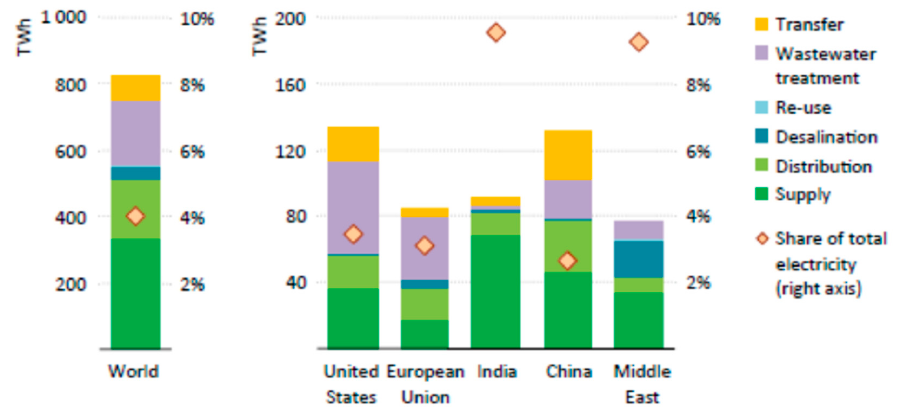
Figure 3. Electricity consumption in the water sector by process and region in 2014 [31]. Supply includes water extraction from groundwater and surface water as well as water treatment. Transfer refers to large-scale inter-basin transfer projects.